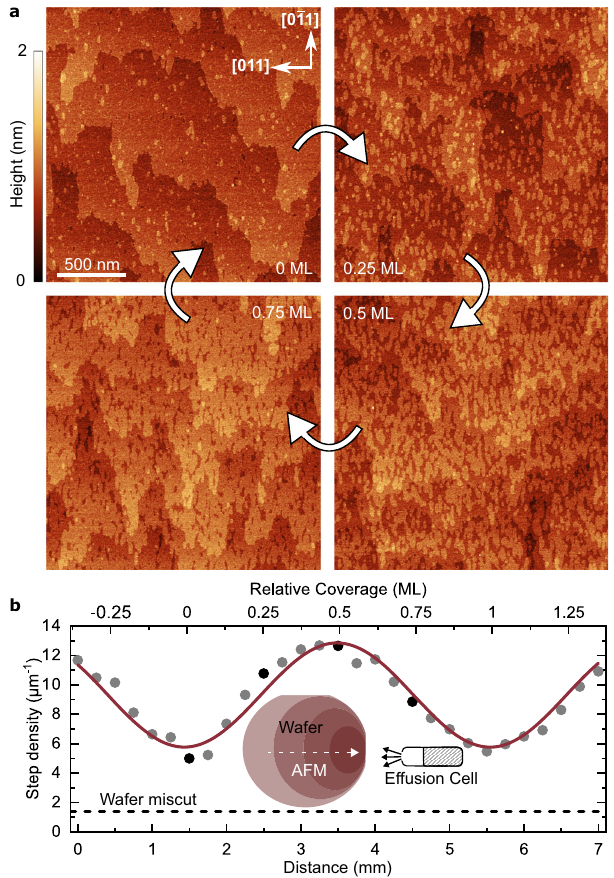
Fig. 2 Atomic force microscopy measurements of a surface pattern de fi ning layer. a AFM maps of GaAs surfaces after a coverage of 0, 0.25, 0.5 and 0.75 ML relative to the location of the lowest step density. b Step density (circles) determined from AFM measurements along the thickness gradient of the PDL (white dashed line in the inset wafer illustration) and sinusoidal fi t (red line). The black circles correspond to the four images in ( a ). The calculated step density originating from the wafer miscut in the horizontal [011] direction is marked by the dashed black line and is determined from average terrace